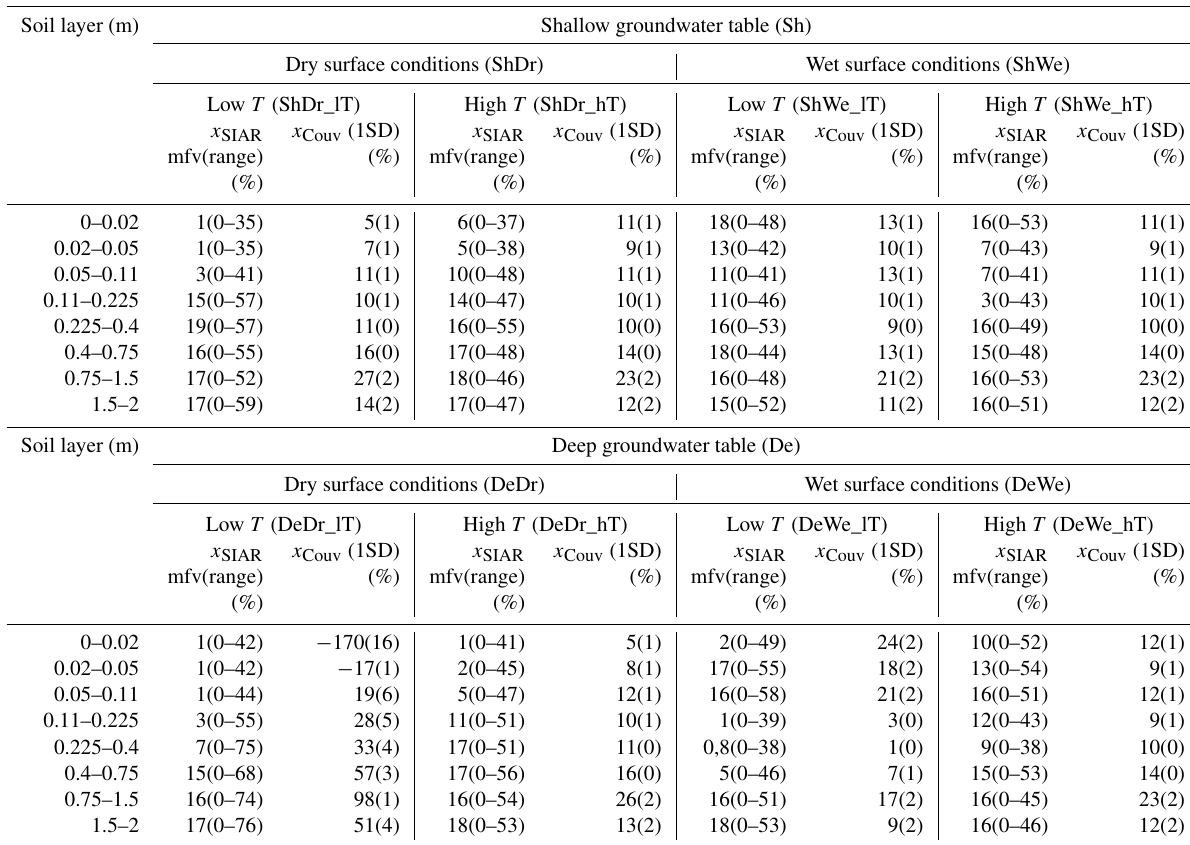
Table 3. Most frequent value (mfv) and range of the density distribution curve of the relative contribution to transpiration across eight defined soil layers as determined by the Bayesian method of Parnell et al. (2010) ( x SIAR , %) and the mean relative contribution (with standard deviation) provided by the analytical model of Couvreur et al. (2012) ( x Couv , %). Profiles of relative contribution were computed for eight soil–plant virtual experiments differing in the depth of the groundwater table (shallow – Sh/deep – De), the soil surface water status (dry – Dr/wet – We), and the plant transpiration rate (low – lT/high –